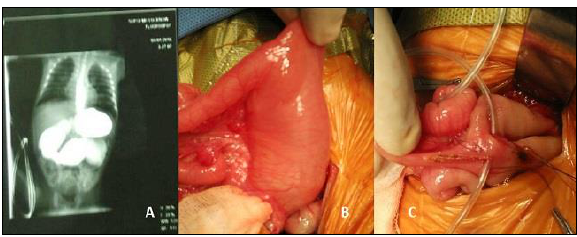
Figure 1: (A) Contrast study showing hugely dilated stomach, duodenum, and proximal jejunum; (B) Peroperative findings of jejunal web; (C) Wind-sock web with central